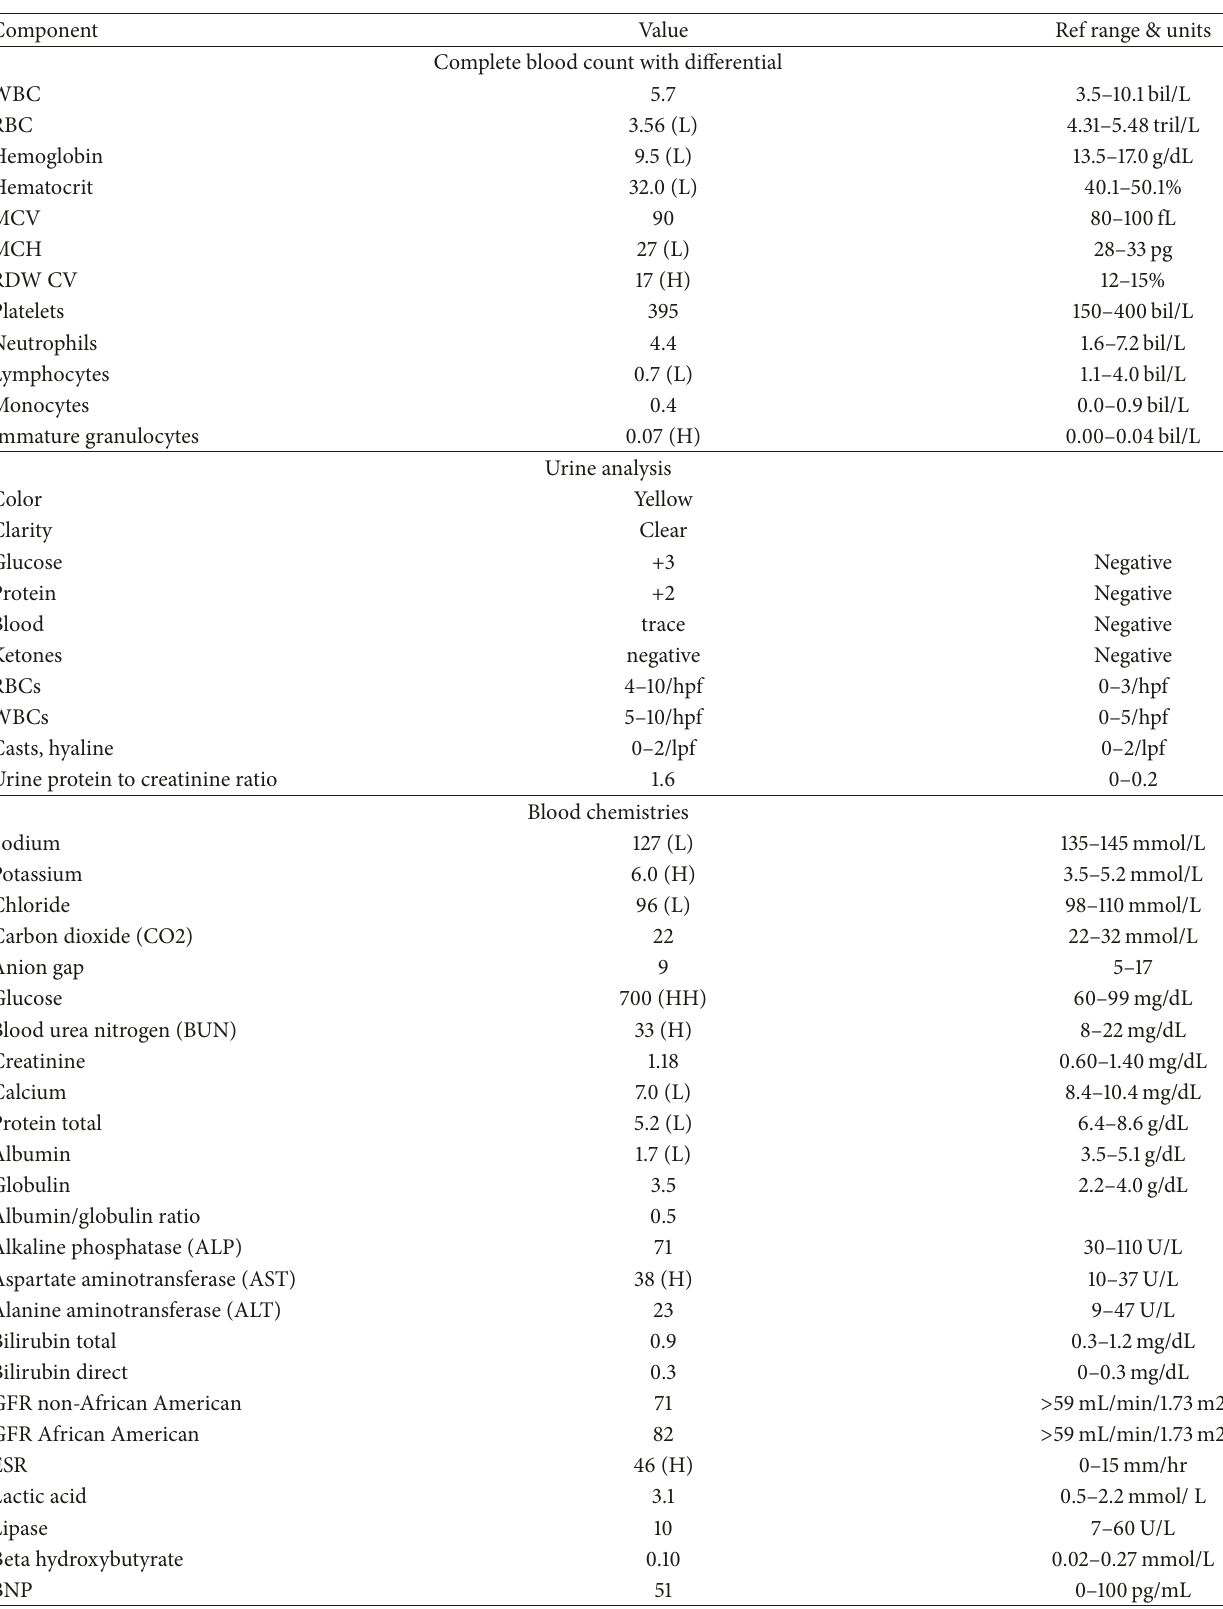
Table 1: Patient’s laboratory values upon